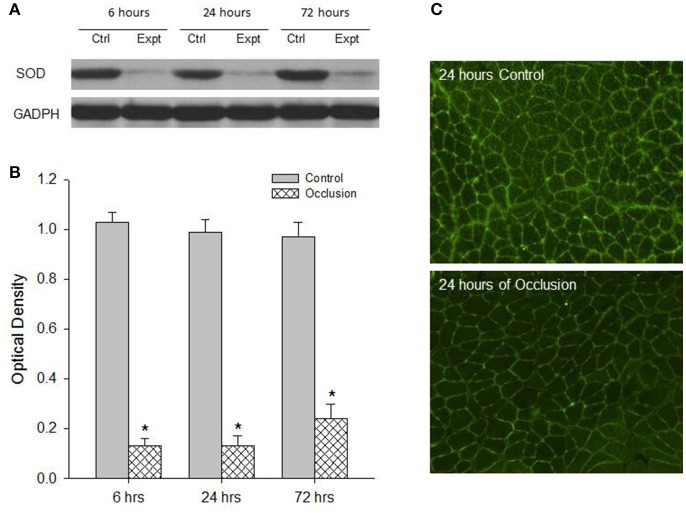
Analysis of SOD protein expression in the red muscle tissues of control limbs and limbs with 6–72 h of femoral artery occlusion. Western blot analysis was performed on muscle tissues from control limbs and occluded limbs. (A) Shows representative bands of SOD expression. Bands of GADPH were used as a control for equal protein loading. (B) Shows average data. *P < 0.05 vs. control group, n = 6 in each group. No significant difference in SOD expression was observed among different time courses. Immunofluorescence methods were used to localize expression of SOD within the red muscles of control limbs and occluded limbs. (C) Typical images showing that SOD appears in the red muscles and the less fluorescence staining is observed in the muscle of occluded limbs.